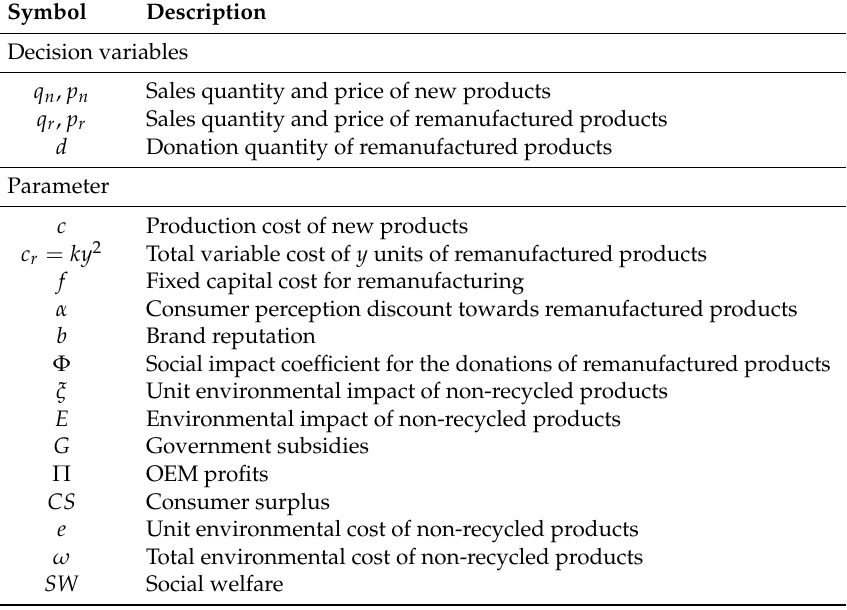
Table 1. Description of Related